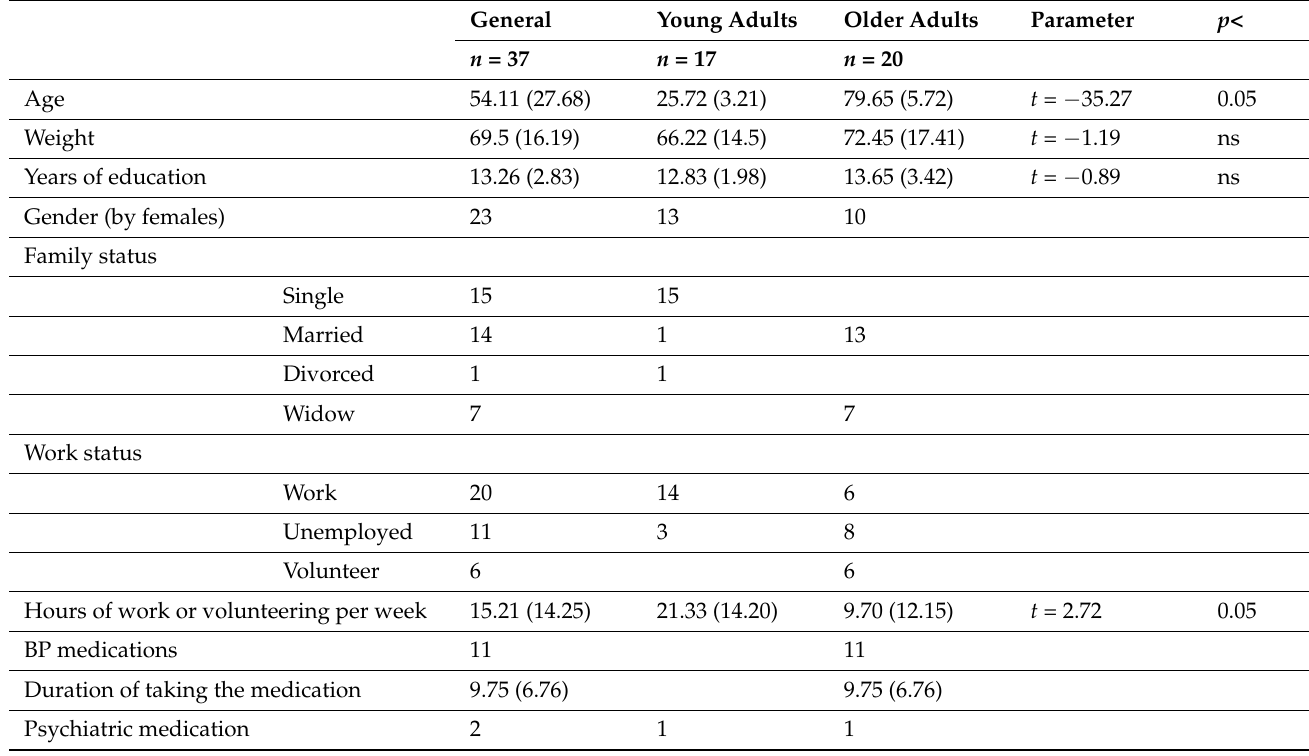
Table 1. Experiment 1—demographic